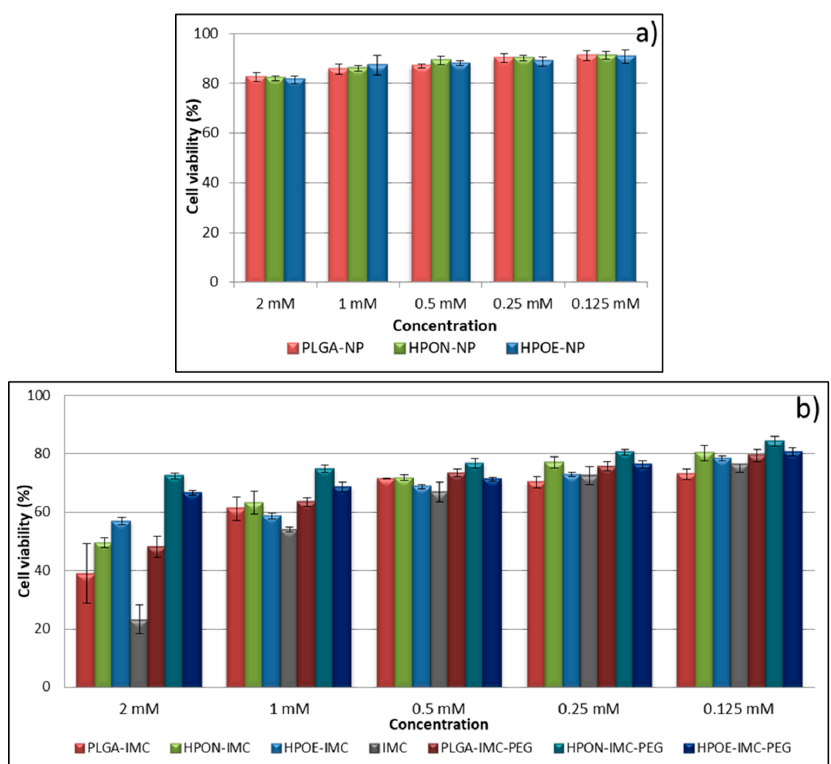
Figure 9. In vitro viability of L929 fibroblast cells line treated with various concentrations of ( a ) empty nanocarriers and ( b ) IMC- loaded into formulations. nanocarriers and ( b ) IMC- loaded into